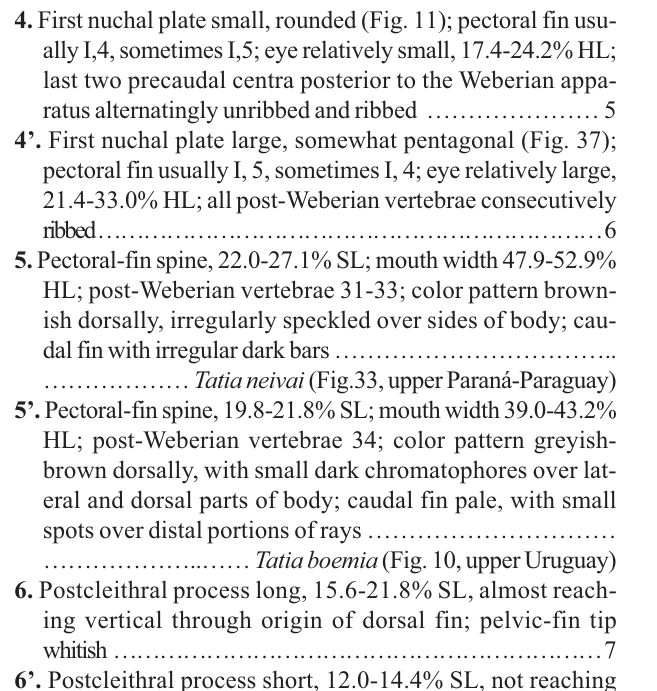
dal fin with irregular dark bars ……………………………..